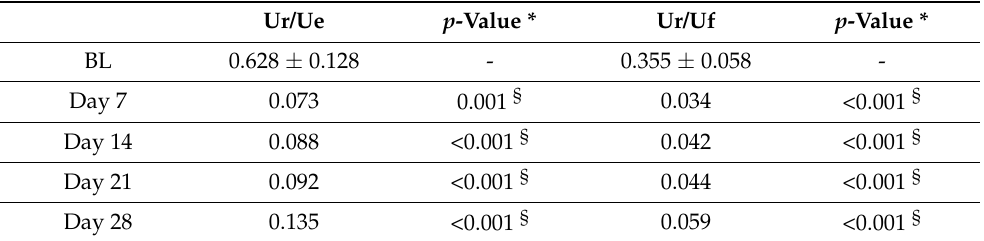
Table 6. Changes from baseline in elasticity parameters after single application of Emollient 2 (first 48 h) followed by once-daily application for 26 days. Ur/Ue p -Value